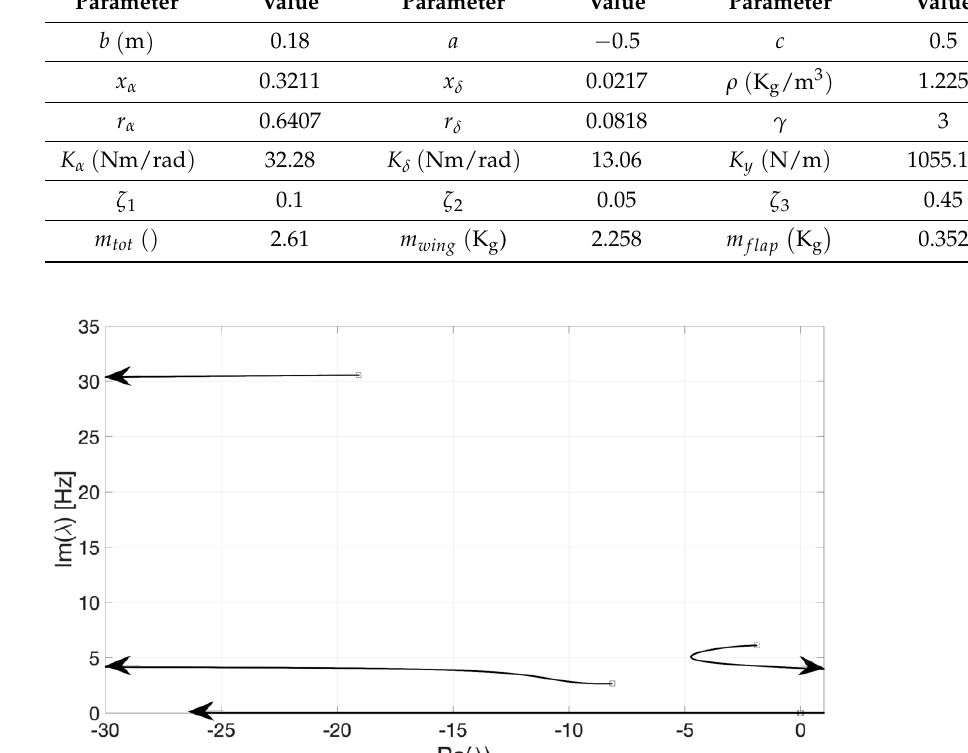
Figure 7. Root locus.